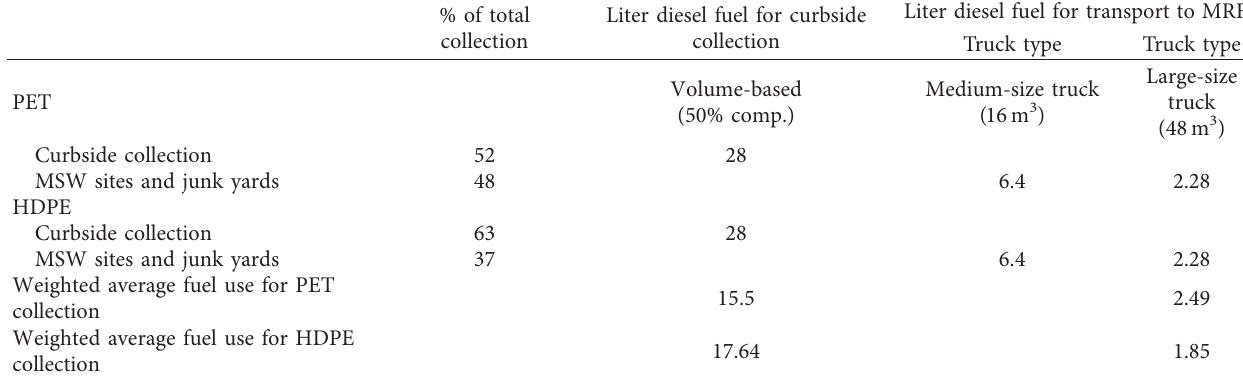
Table 4: Total fuel used for collection of 1 ton of the postconsumer plastic (including two methods).